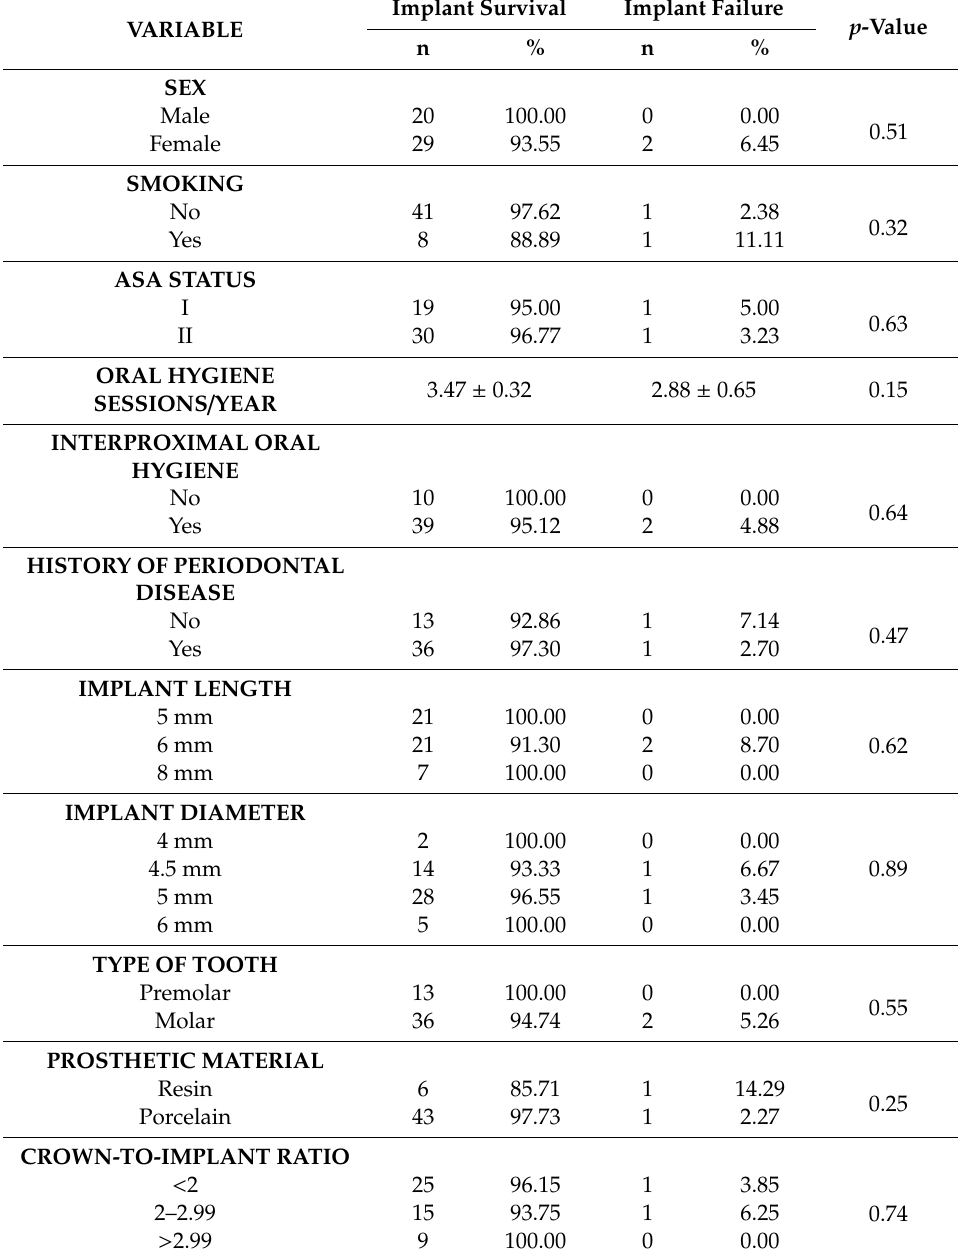
Table 2. Analysis of implant survival according to included study covariates. For all variables, values are presented as n